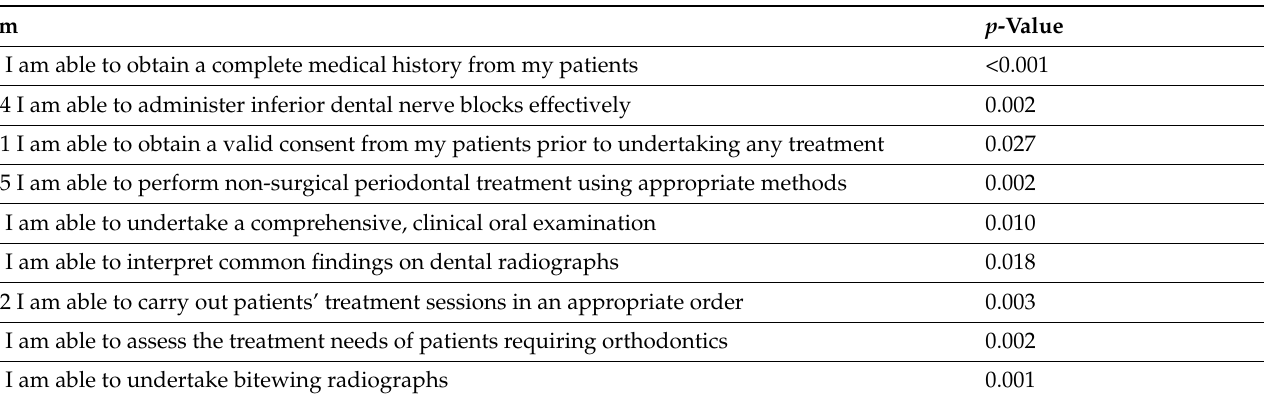
Table 2. Association between Gender and Item Responses for Part A: Specific p -values from Chi- Squared tests of association for items showing a statistically significant association between Gender and Item Responses for Part A.